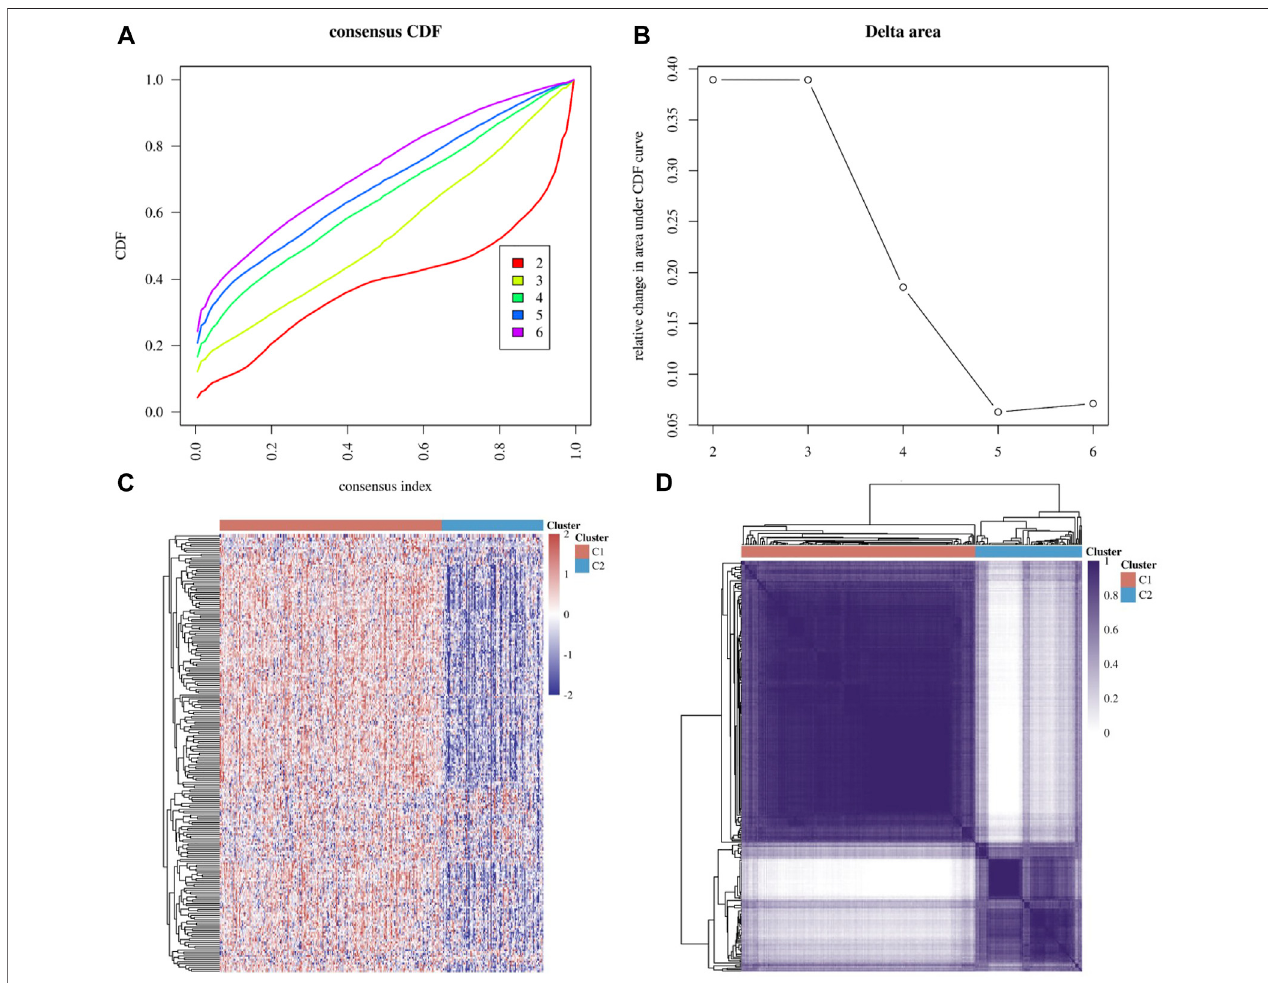
FIGURE 1 | Molecular subgroup based on DNA damage repair genes. (A,B) Delta area curve of consensus clustering, indicating the relative change in area under thecumulativedistributionfunction(CDF)curveforeachcategorynumberkcomparedwith k − 1. (C) HeatmapofDNAdamagerepair-relatedgeneexpressionindifferent subgroups, red represents high expression and blue represents low expression (D) Heatmap depicting consensus clustering solution ( k = 2) for DNA damage repair genes.